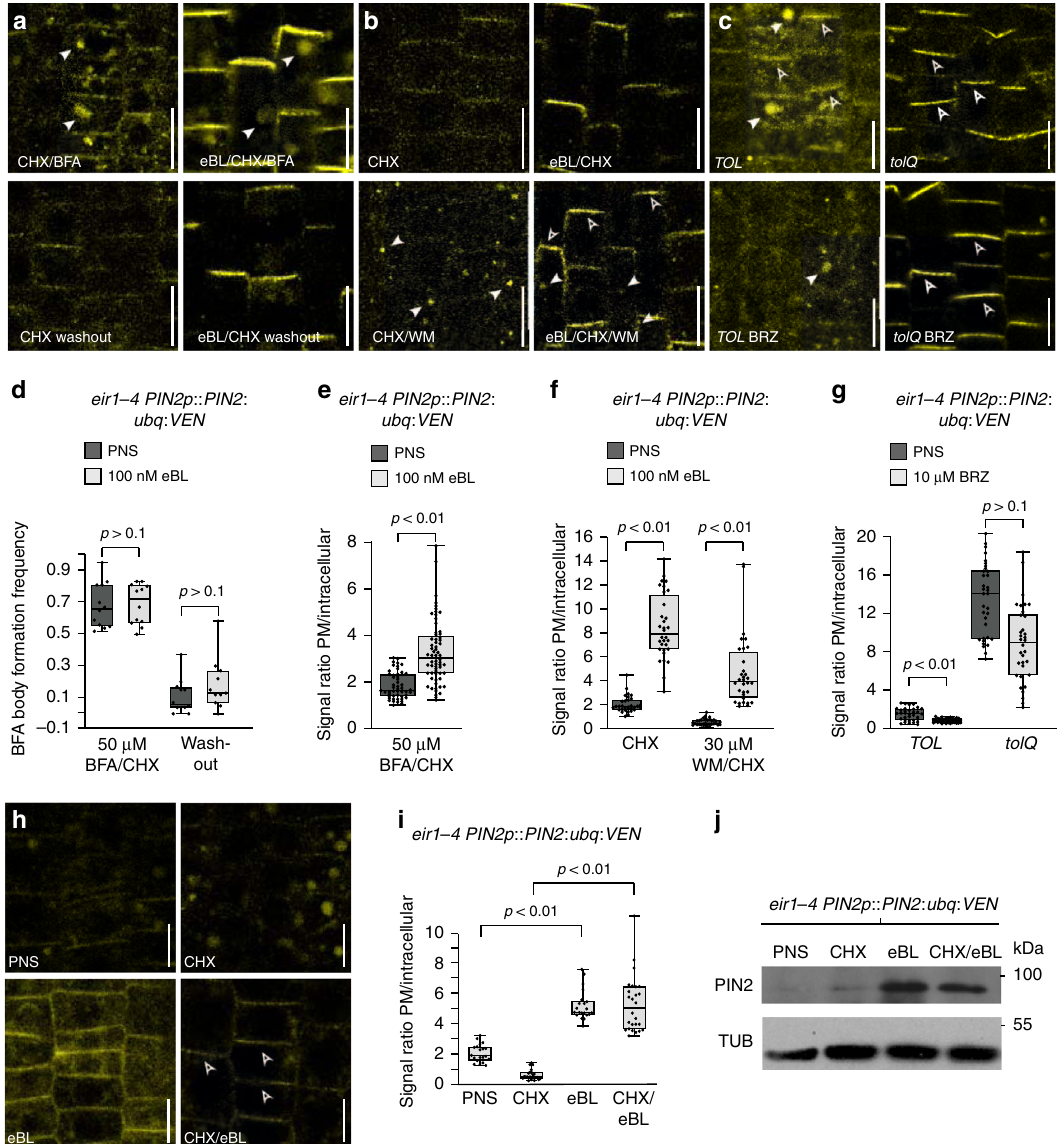
Fig. 3 Brassinolide antagonizes endocytic sorting of constitutively ubiquitylated PIN2. a 6 DAG eir1-4 PIN2p::PIN2:ubq:VEN on PNS, or treated with 100 nM eBL for 16 h, followed by 50 μ M CHX or 100 nM eBL/50 μ M CHX treatment for 30 ′ , and by co-incubation for 60 ′ in the presence of 50 μ M CHX/ 50 μ M BFA and 100 nM eBL/50 μ M CHX/50 μ M BFA. White arrowheads: BFA-induced compartments. b 6-day-old eir1-4 PIN2p::PIN2:ubq:VEN grown on PNS or treated with 100 nM eBL for 16 h, followed by treatment with 50 μ M CHX for 30 ′ (CHX), or co-treated with eBL and CHX for 30 ′ (eBL/CHX). This was followed by co-incubation in the presence of either 50 μ M CHX and 30 μ M WM (CHX/WM) or 100 nM eBL, 50 μ M CHX and 30 μ M WM (eBL/ CHX/WM) for another 90 ′ . White arrowheads: PIN2:ubq:VEN signals in WM-induced endocytic compartments; open arrowheads: PM localization. c PIN2: ubq:VEN signals in 6 DAG TOL and tolQ root epidermis cells, on PNS or on 10 μ M BRZ for 16 h. White arrowheads: intracellular signals; open arrowheads: PM localization. d Frequency of BFA-compartment formation observed in ‘ a' ( n = 10 – 12 roots and 230-550 cells/dataset). e Signal ratios for ‘ a' ( n = 8 roots and 52/65 trichoblast cells/dataset). f Signal ratios for ‘ b' ( n = 5 roots and 32 – 33 cells/dataset). g Signal ratios for ‘ c' ( n = 4 roots and 34 cells/dataset). h Root meristem cells eir1-4 PIN2p::PIN2:ubq:VEN seedlings, on PNS (left, top); on 50 μ M CHX for 5.5 h (top, right); on 100 nM eBL for 5 h (bottom, left); on 50 μ M CHX for 30 ′ , followed by eBL/CHX for 5 h (bottom, right). Open arrowheads: signals at the PM. i Signal ratios for ‘ h ’ ( n = 4 roots and 20 – 26 cells/ dataset). j eir1-4 PIN2p::PIN2:ubq:VEN root membrane fractions, probed for PIN2 and TUB ( α -tubulin). Conditions as in ‘ h ’ . Box plot whiskers represent the entire range of outliers; gray boxes: fi rst and third quartiles; center line: median; dots: values obtained. Two-tailed t -test analysis has been performed to test for p -values. Scale bars: a – c, h = 10 μ m. Source data are provided as a Source Data fi